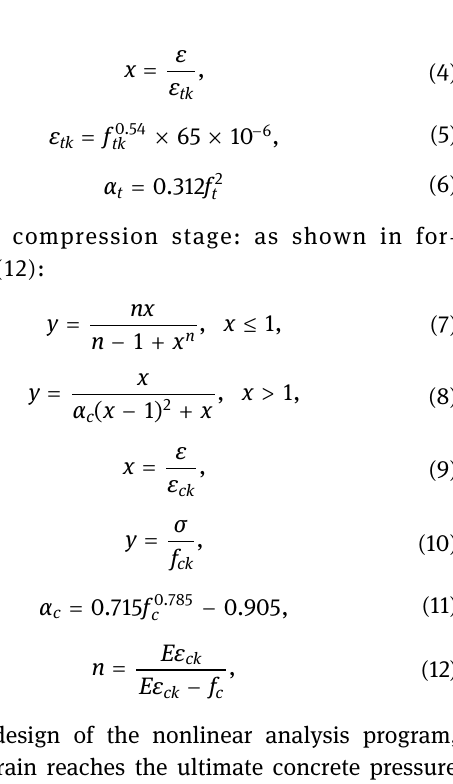
e ff ective algorithm to solve the material constitutive matrix